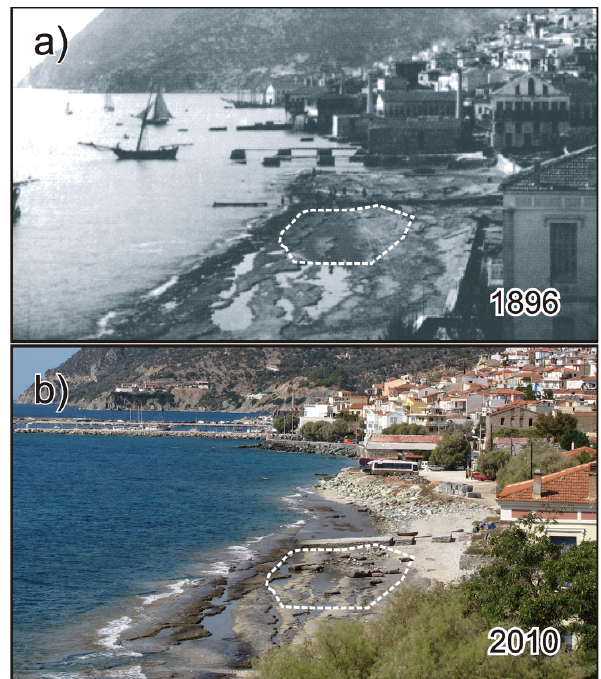
Fig. 5. Plomari in the 1896 (a) and today (b) . Boulder deposits are missing in the 1896’s photograph. The 1896’s photo is extracted from the book “Maritime tradition, boatyards and wooden vessels” (To Polion, 2010).